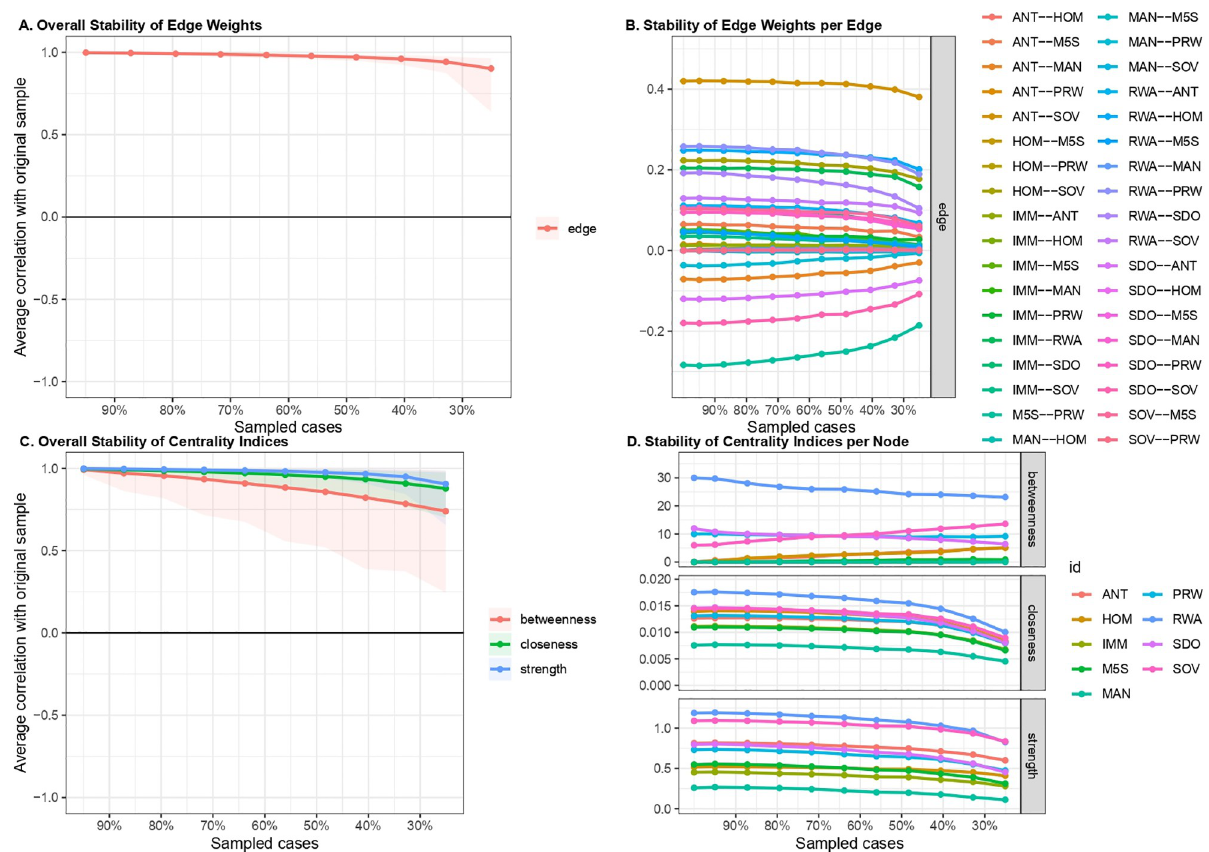
Fig 11. Stability of edge weights and of centrality indices of the integrated beliefs system network. (A) Overall stability of edge weights. (B) Stability of each edge weight. (C) Overall stability of estimated centrality indices. (D) Stability of estimated centrality indices for each node.